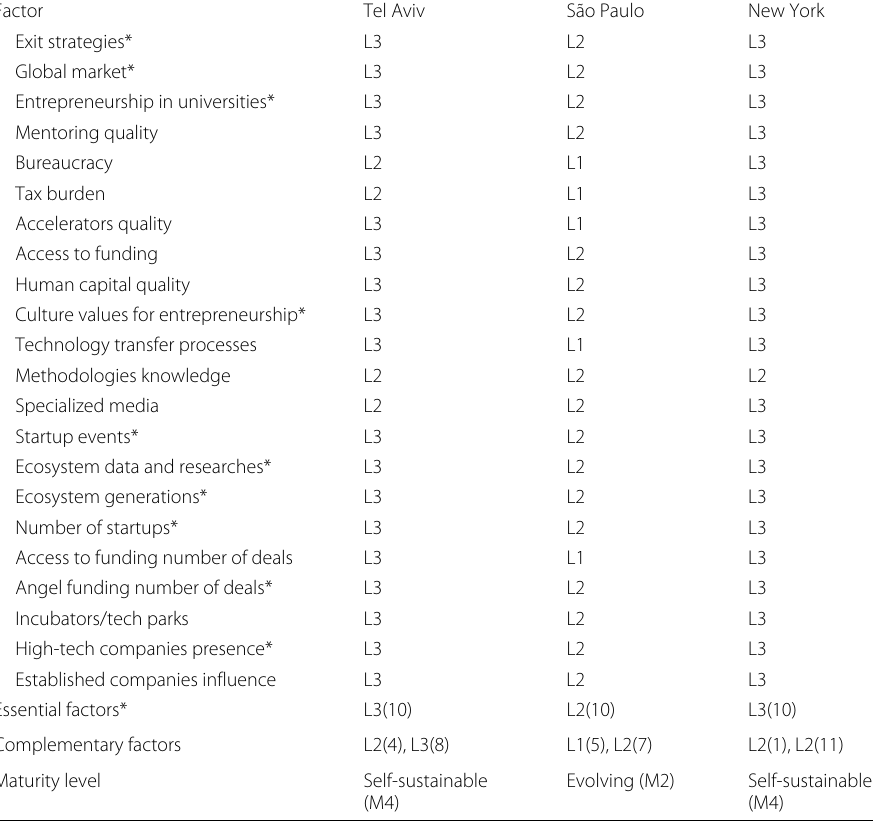
Table 5 Startup ecosystem comparison